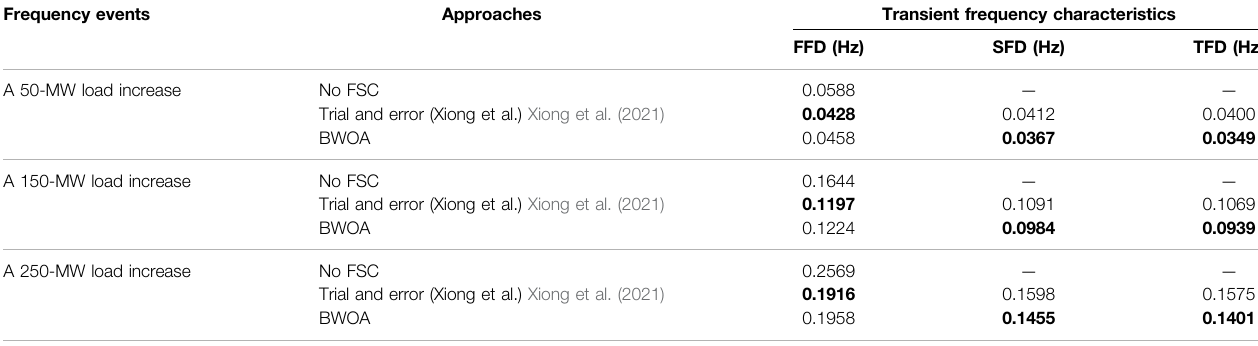
TABLE 4 | FFD, SFD, and TFD obtained by various methods.